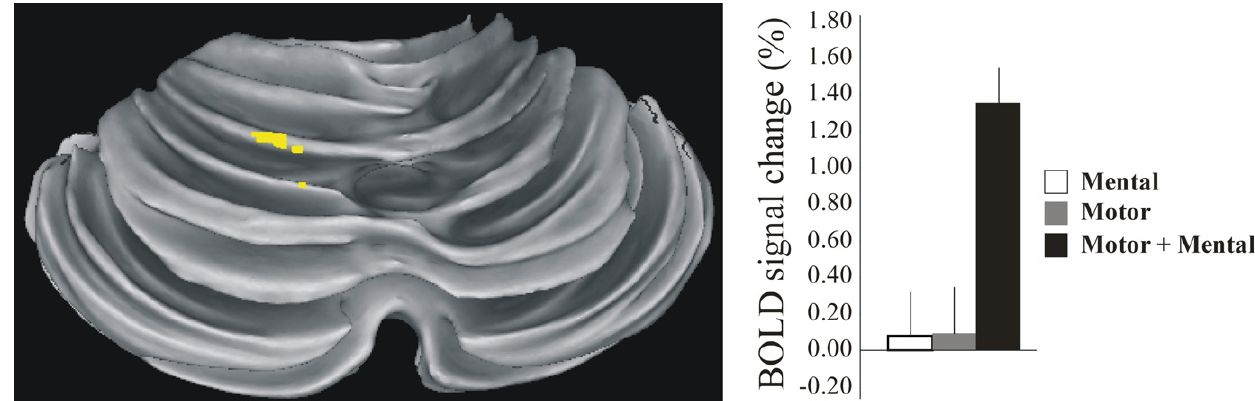
Figure 4 | Increased activity in posterior ipsilateral (left) cerebellum was observed during performance of the untrained sequence (transfer) after combined motor and mental training but not after motor only or mental only training. Bars indicate the BOLD signal change in relation to the mean BOLD- value over the session, with error bars denoting standard